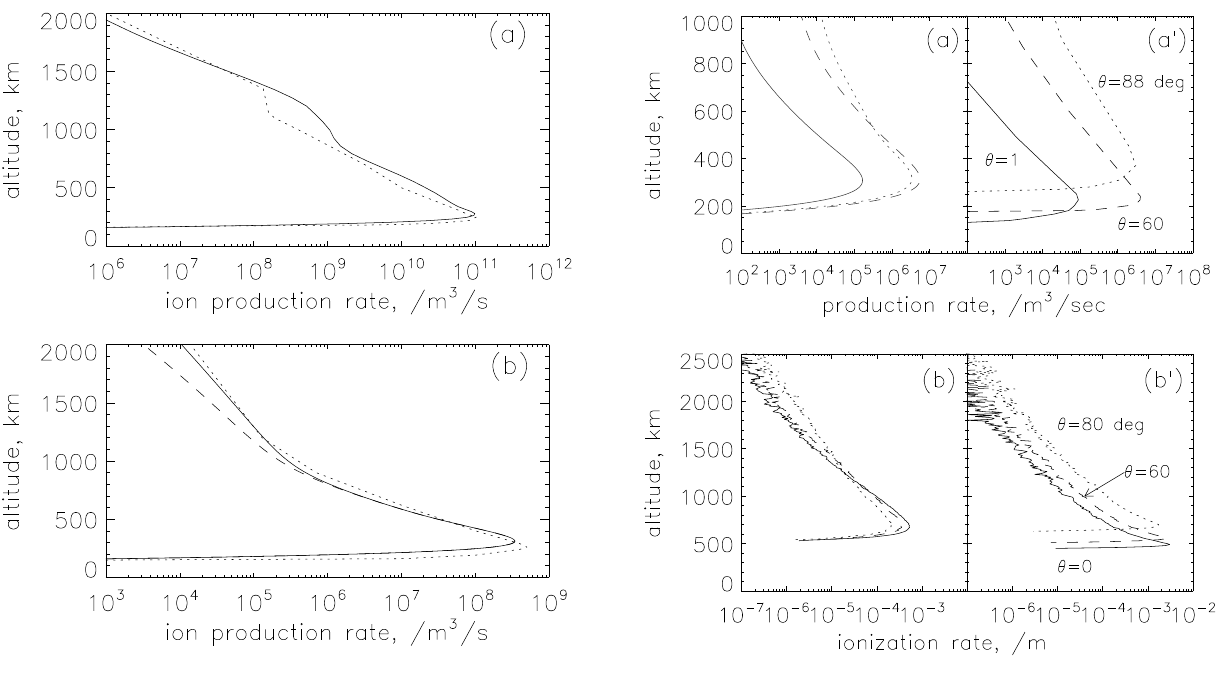
Figure 10: 2007.12.18: Y. Hiraki and C. Tao